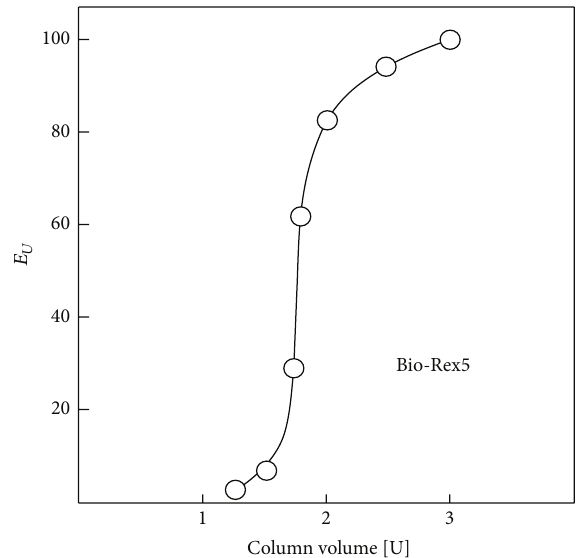
Figure 9: U-elution with 4M HNO 3 .